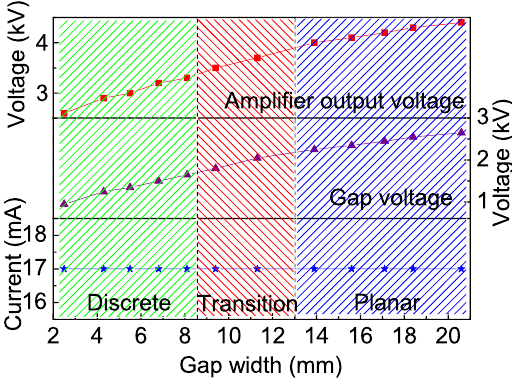
Figure 3. Amplifier output voltage, gap voltage and discharge current as functions of the gap width.